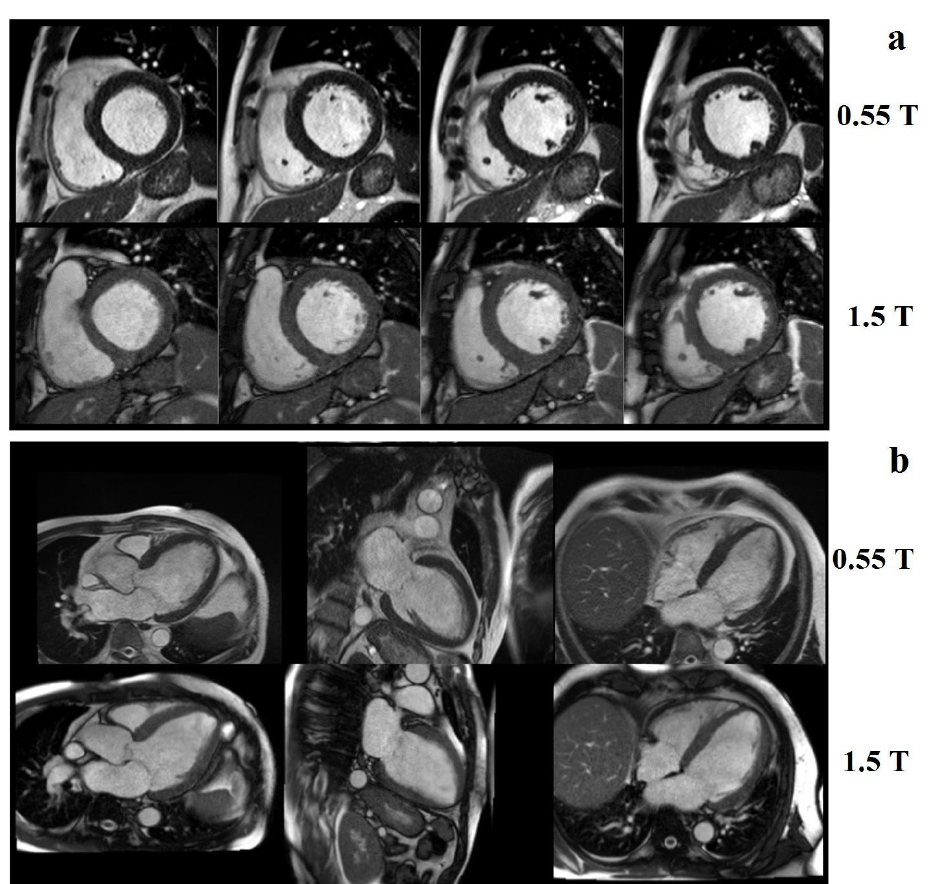
Figure 10. Examples of image quality at 0.55 T and 1.5 T breath-held, cine-steady, state-free precession: ( a ) short axis and ( b ) long axis slices from a patient with a nonischemic cardiomyopathy. Reprinted from [48].